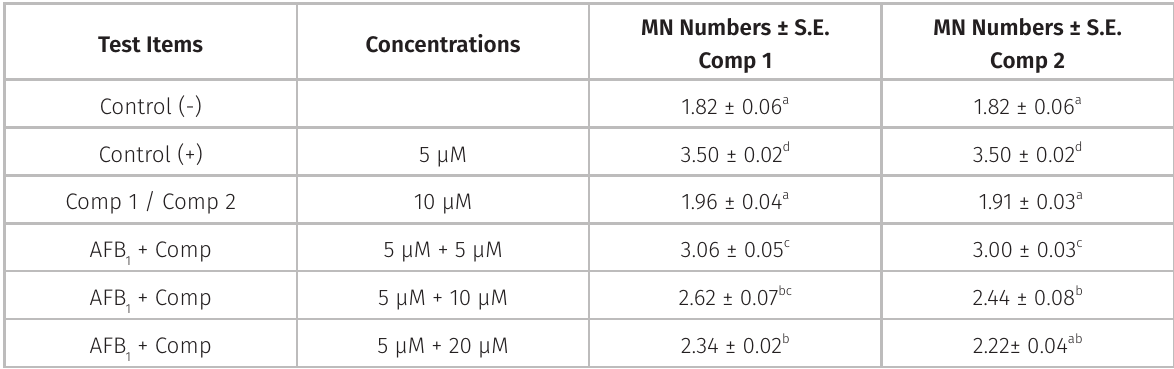
Table II. The effects of AFB1 and Comp 1 / Comp 2 on MN.